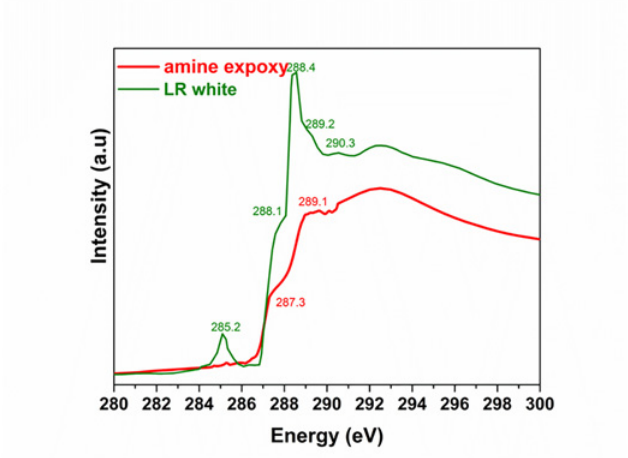
Fig 8. Carbon 1s soft X-ray absorption spectra of LR white and amine epoxy resin.